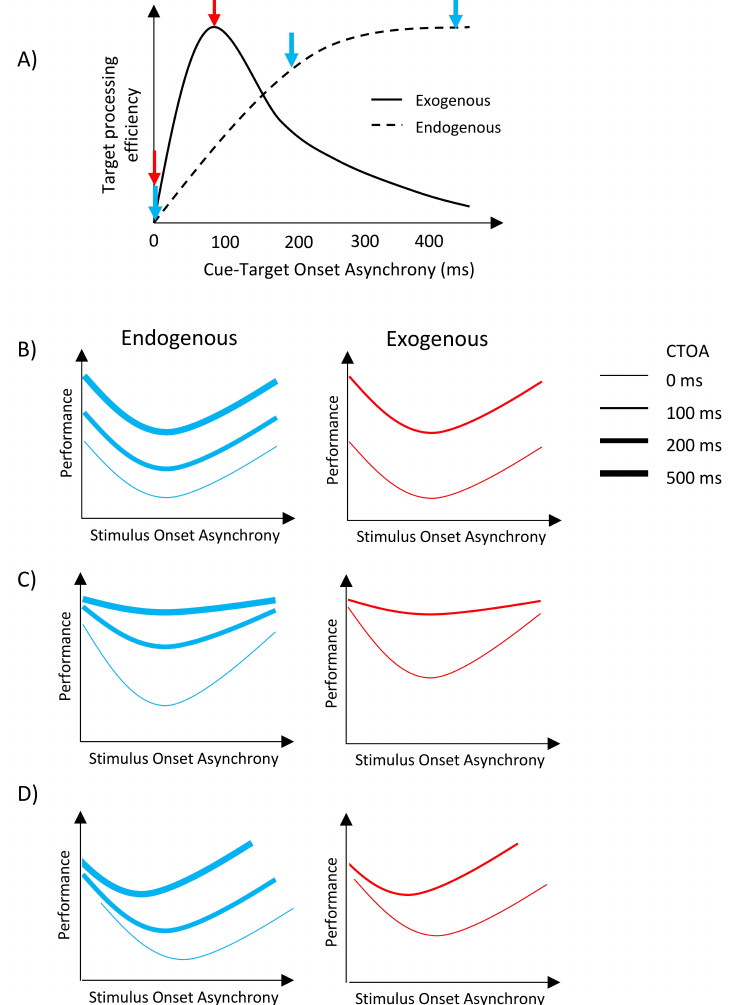
Figure 2. ( A ) The time courses of effects of exogenous (solid line) and endogenous (dashed line) cueing [68]. The blue and red arrows indicate endogenous and exogenous cues, respectively. ( B ) The predicted outcomes assuming no interaction between attention and masking. ( C , D ) Possible outcomes that would indicate interactions between metacontrast and